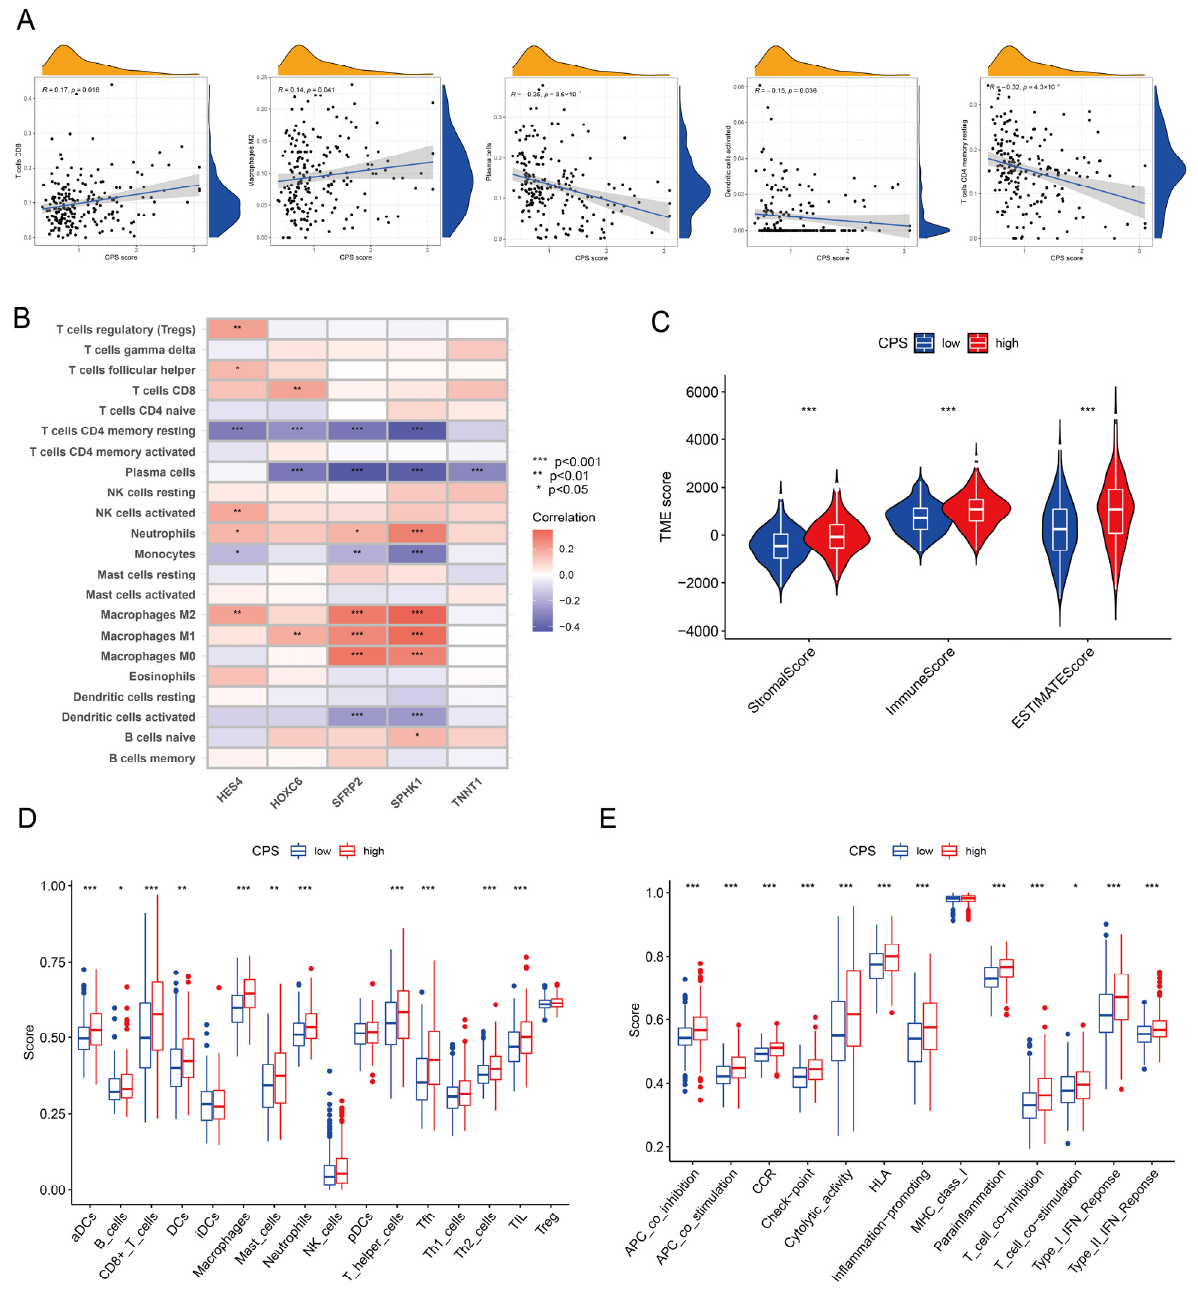
Figure 6. Extended application of CPS score in the immune landscape. ( A ) Correlation analysis between CPS score and immune infiltrating cells. ( B ) Correlation between model-built genes and immune cells. ( C ) ESTIMATE analysis of diverse CPS-score subgroups. ( D ) ssGSEA analysis of diverse CPS-score subgroups for immune infiltrating cells and ( E ) immune-related function. ssGSEA, single-sample gene set enrichment analysis. * p < 0.05; ** p < 0.01; *** p < 0.001.